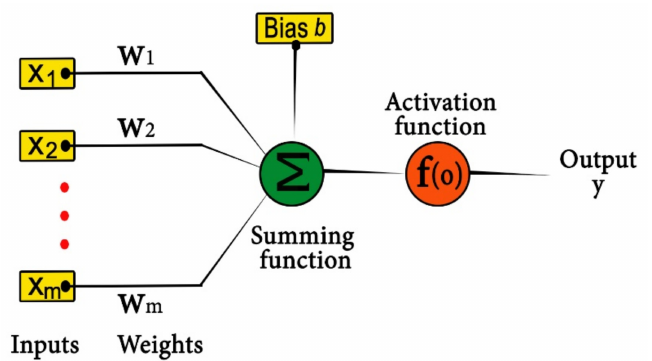
Figure 3. Model of network